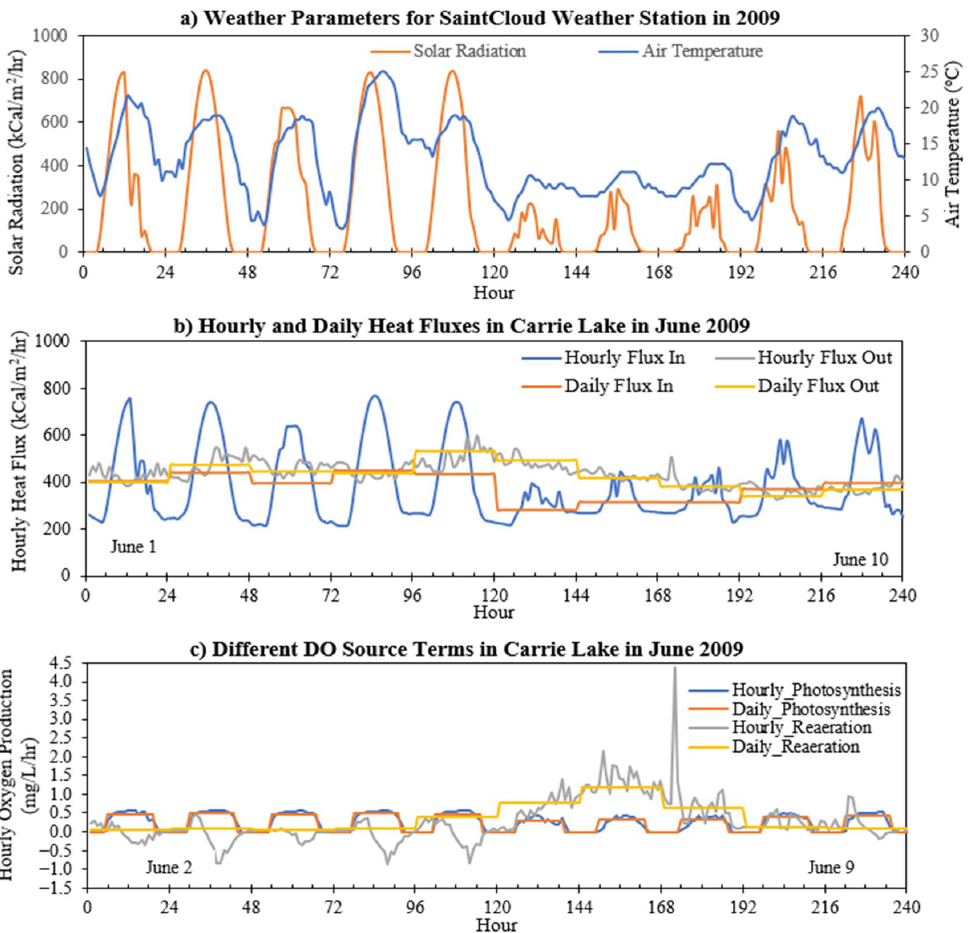
Figure 7. Time series of ( a ) air temperature and solar radiation, ( b ) calculated daily and hourly heat fluxes, and ( c ) two DO source terms through the water surface at Carrie Lake on 1–10 June 2009.